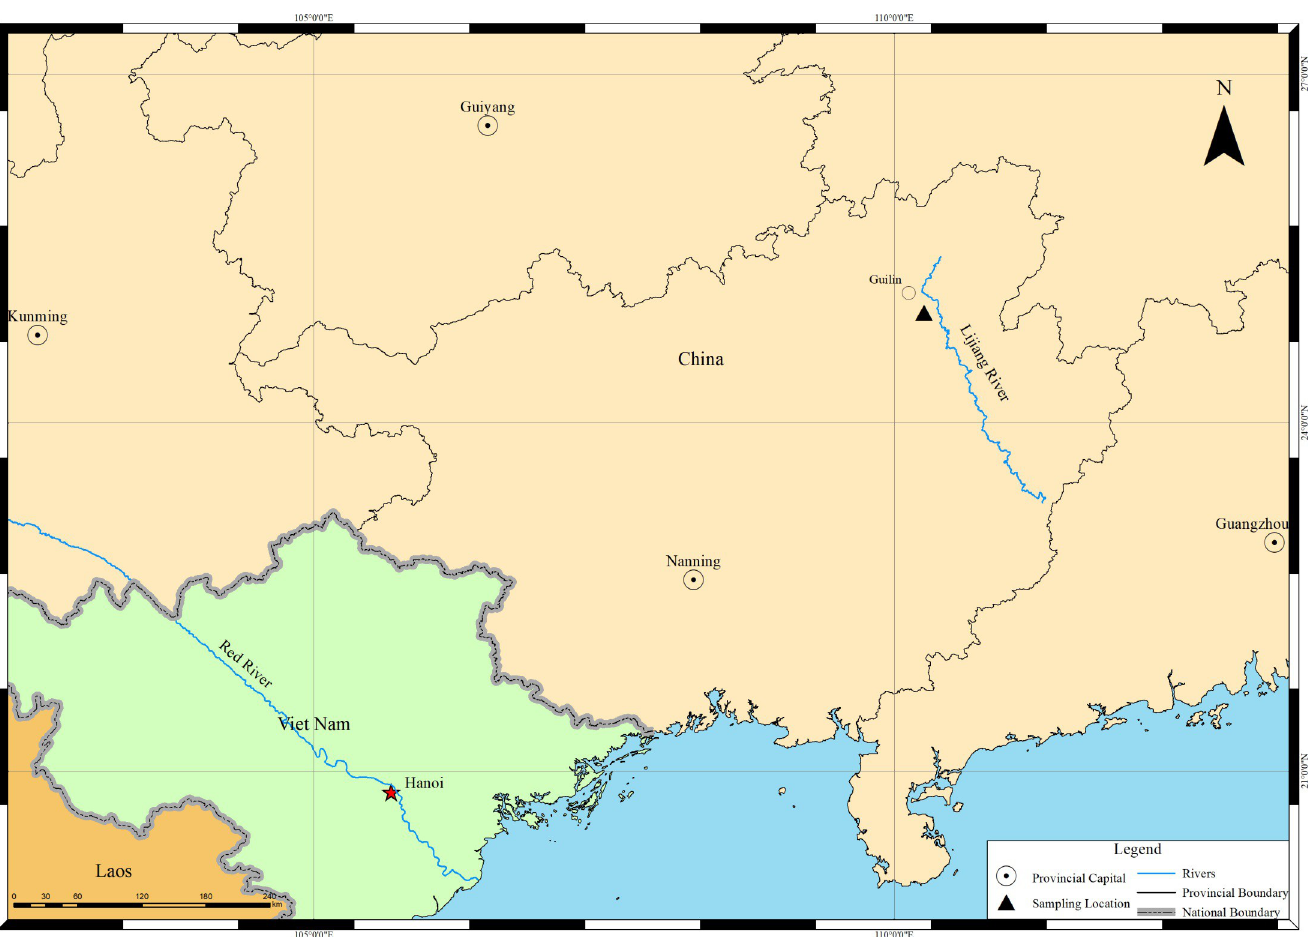
Fig 1. Map of sampling